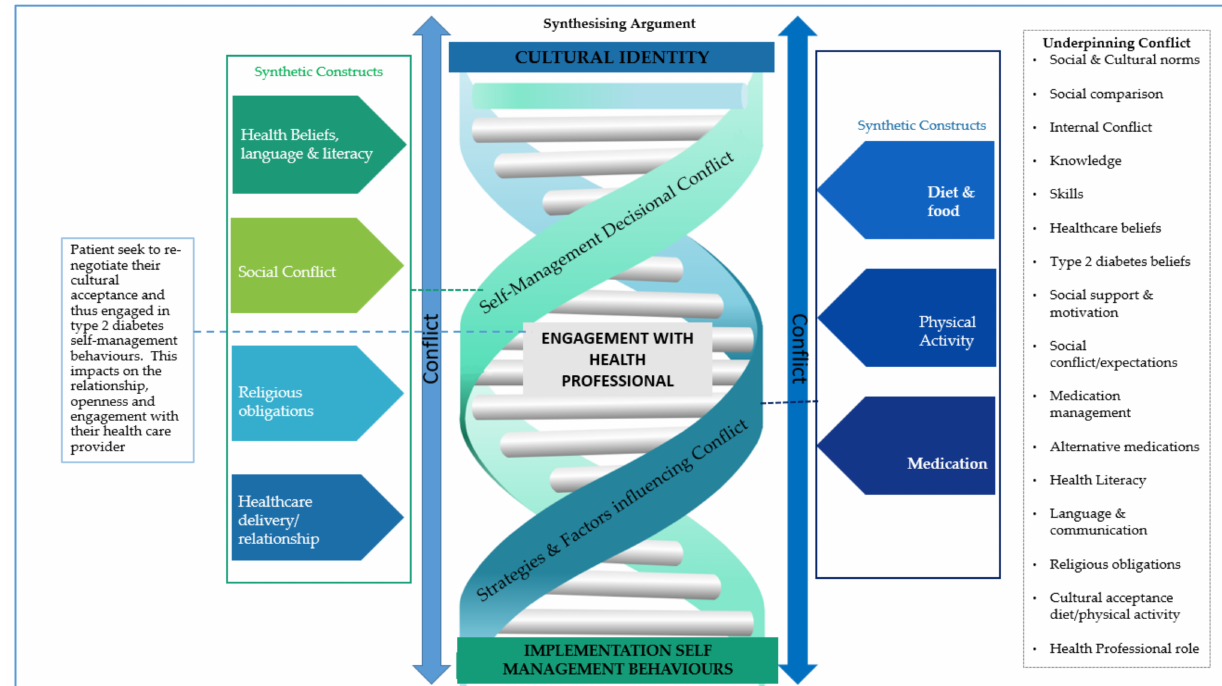
Figure 2. Model of synthesizing